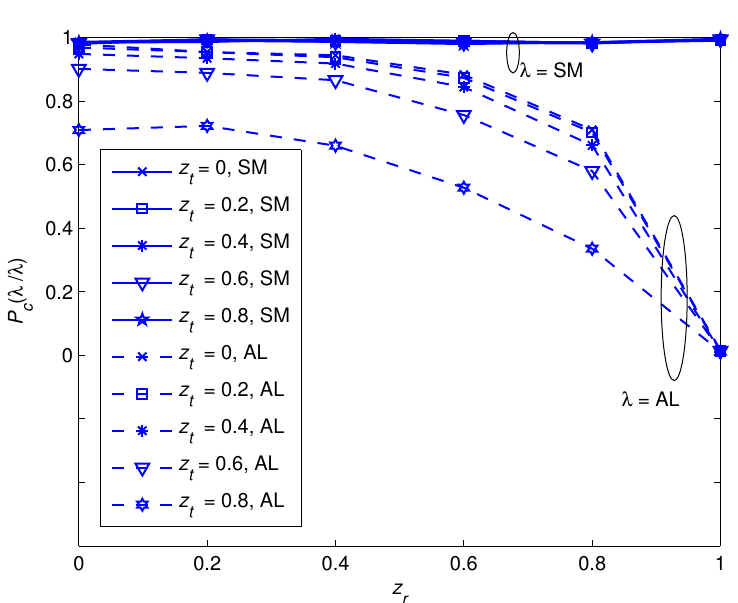
Figure 6. Effect of z t and z r on the classification performance of combiner and detector 2 with = 10 − 3 . f n d